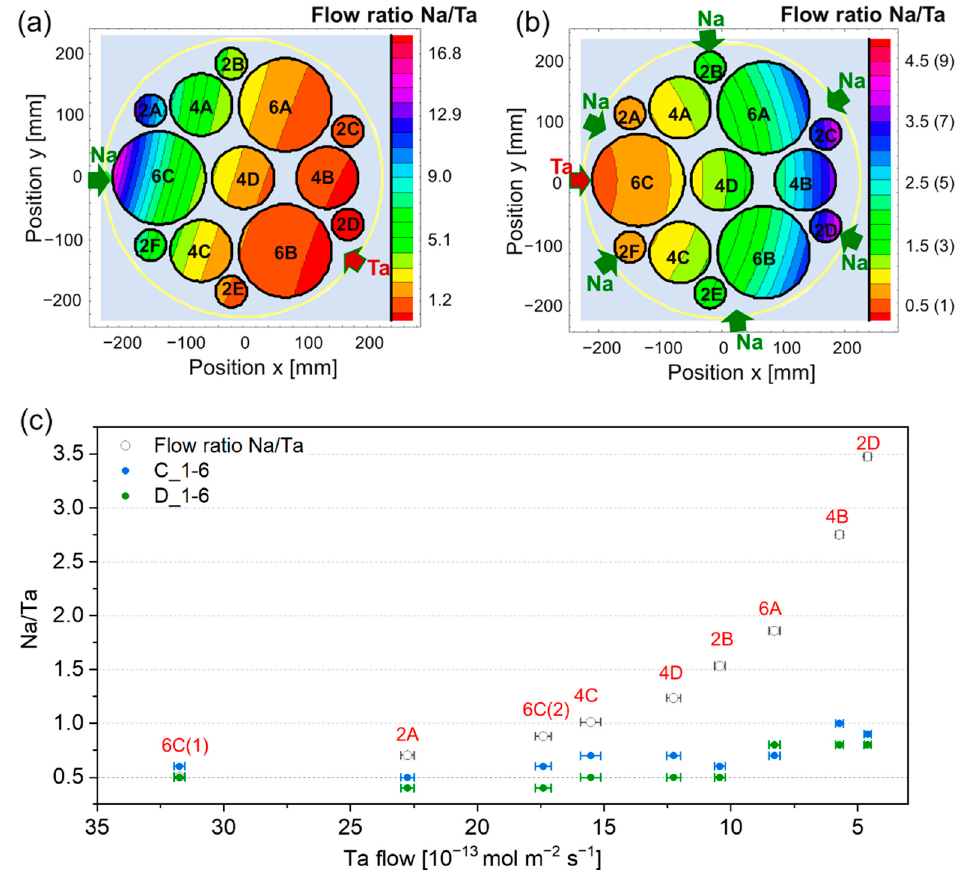
Figure 3. Flow simulations for ( a ) 1-1 and ( b ) 1-6 batches. In the latter case, scale values for Na/Ta flow ratios are for depositions C and D (target VP Na = 0.01 mbar), while values in brackets are for depositions A and B (target VP Na = 0.02 mbar). ( c ) Comparison between the measured Na/Ta by XPS and Na/Ta calculated from flow simulations in batches C_1-6 and D_1-6. For the position of the samples and active sources, refer to Figure 2. Error bars refer to the Ta flows calculated at ± 5 mm away from the point where thickness measurements were performed, thus considering possible measurement errors related to the positioning of the sample.